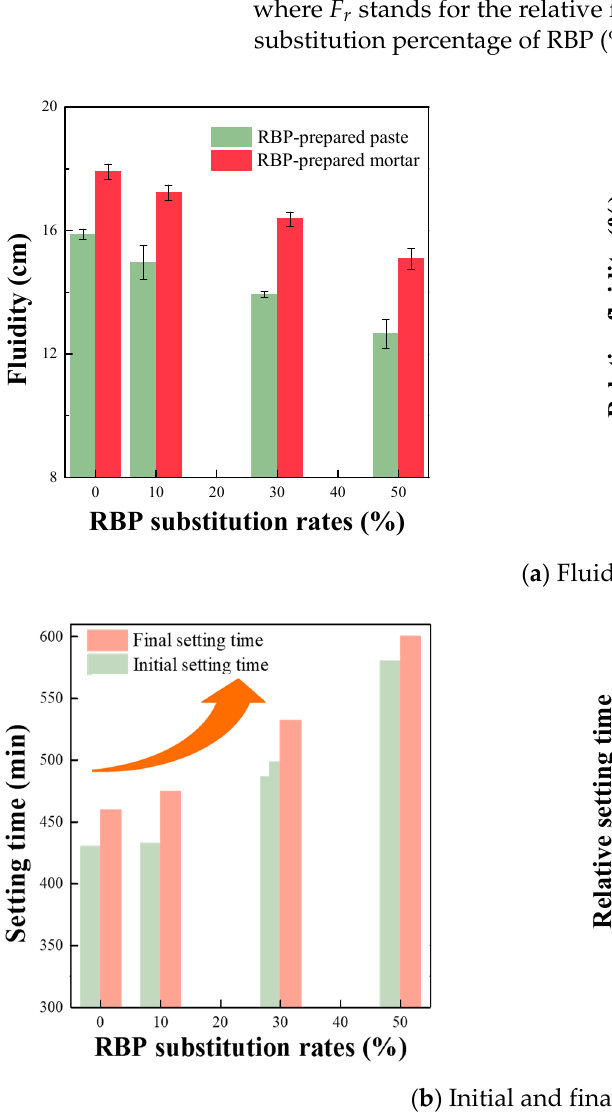
Figure 8. Fluidity and setting time of cementitious materials with various RBP substitution